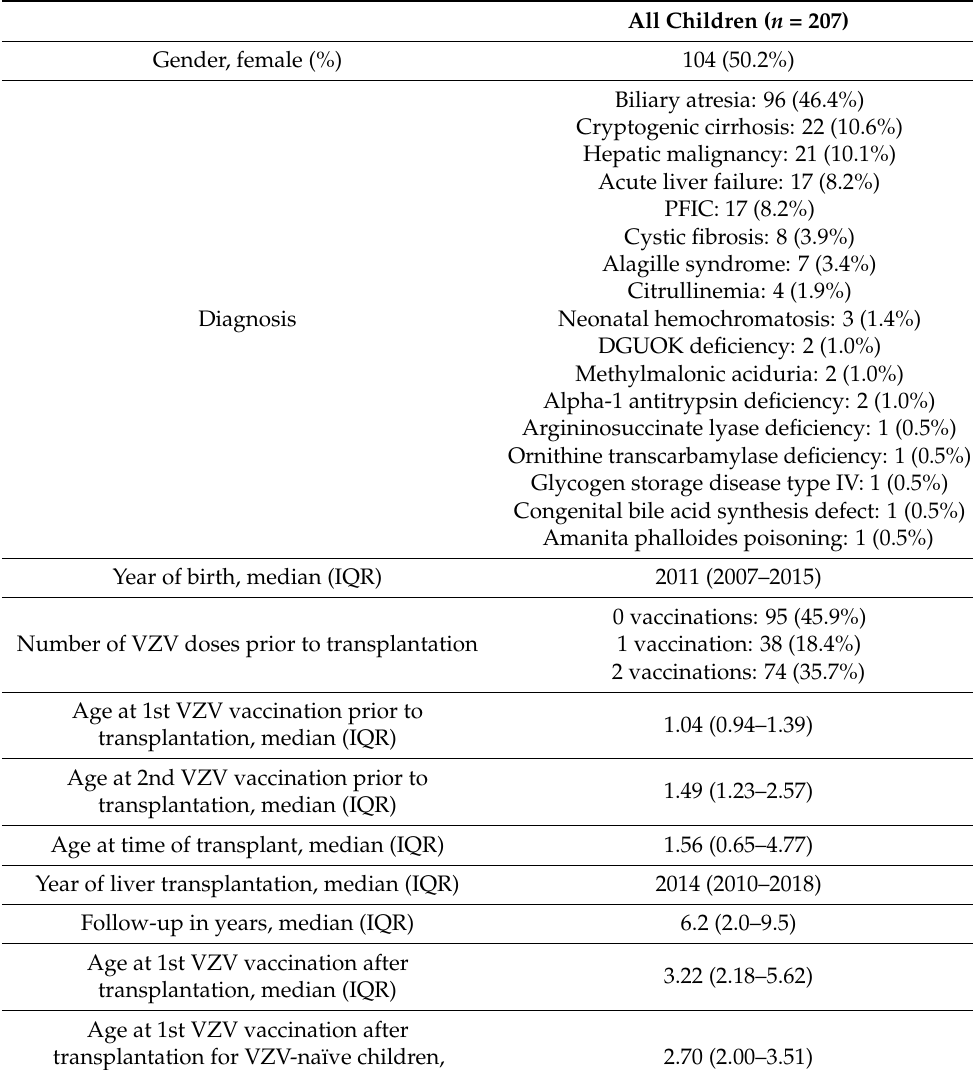
Table 1. Patient data of 207 children with an available vaccination record who underwent liver transplantation between September 2004 and June 2021 at Hannover Medical School